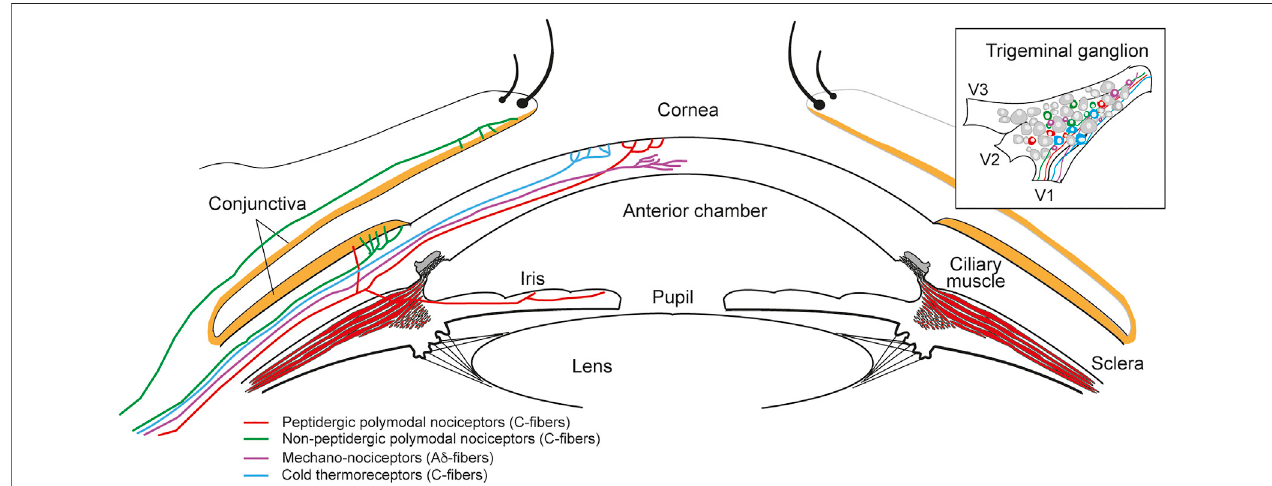
FIGURE 1 | Sensory innervation of the ocular anterior segment. Diagram of the anterior part of the eye showing the different types of nerve fi bers innervating the different structures and the ocular surface. Sensory innervation is provided by the ophthalmic nerve arising from the V1 branch of the trigeminal ganglion (upper right